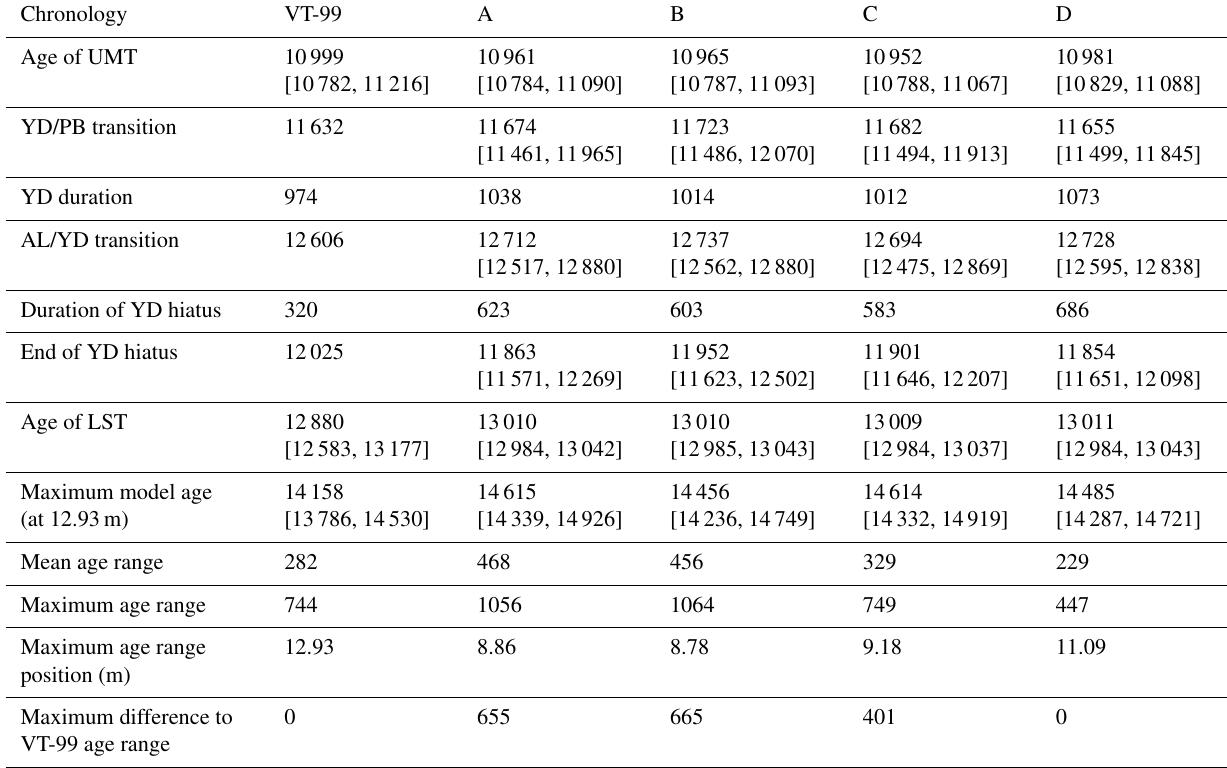
Table A6. Age estimations for VT-99 and Models A–D with their 95% confidence intervals in brackets for the Ulmener Maar Tephra (UMT), the Younger Dryas–Preboreal-transition (YD/PB), the YD duration, the Allerød–Younger Dryas-transition (AL/YD), the predicted YD hiatus with duration and position, the Laacher See Tephra (LST), the maximum model age at 12.93m with its mean and maximum age ranges, the position of the maximum age range, and the maximum difference between VT-99 and each of the model ranges.